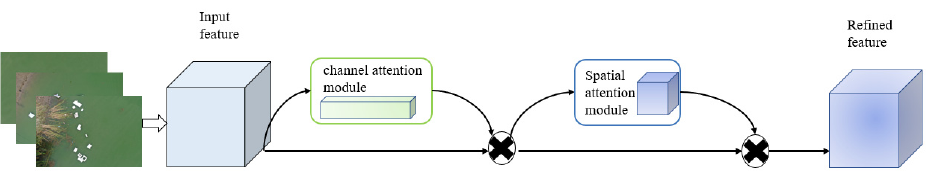
Figure 8. CBAM structure diagram.